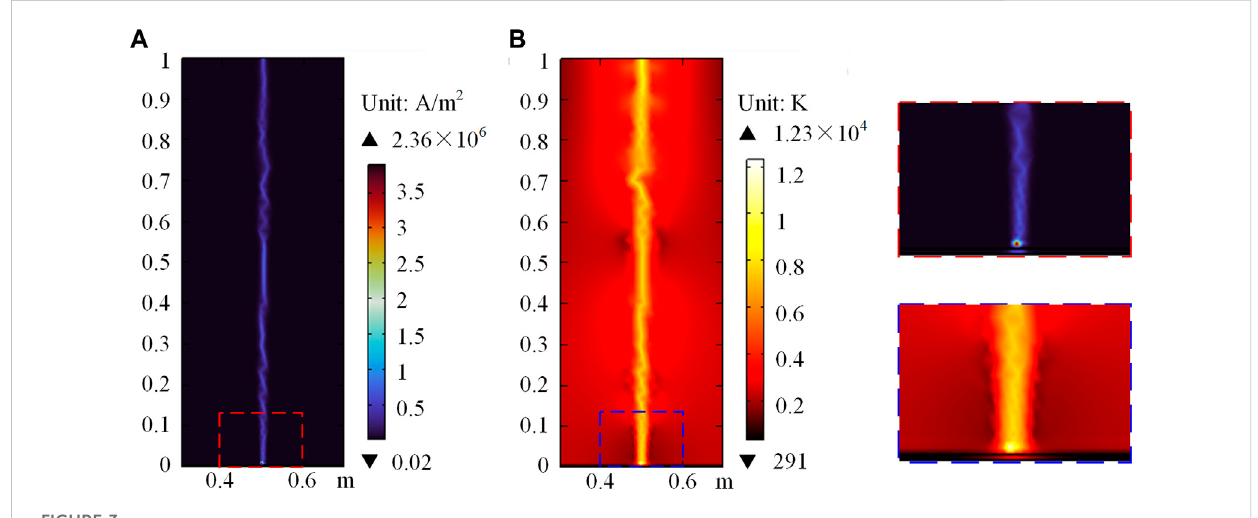
FIGURE 3 Calculation results at 100 ms after arc ignition: (A) current density and (B)